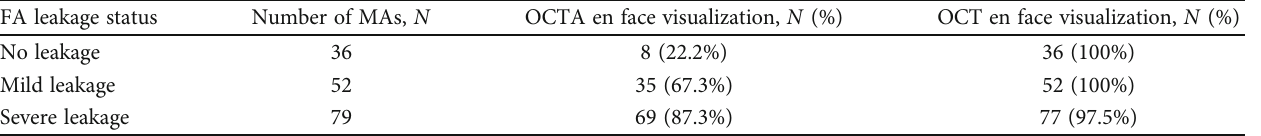
Table 3: FA leakage status and OCTA/OCT en face visualization of diabetic MAs.